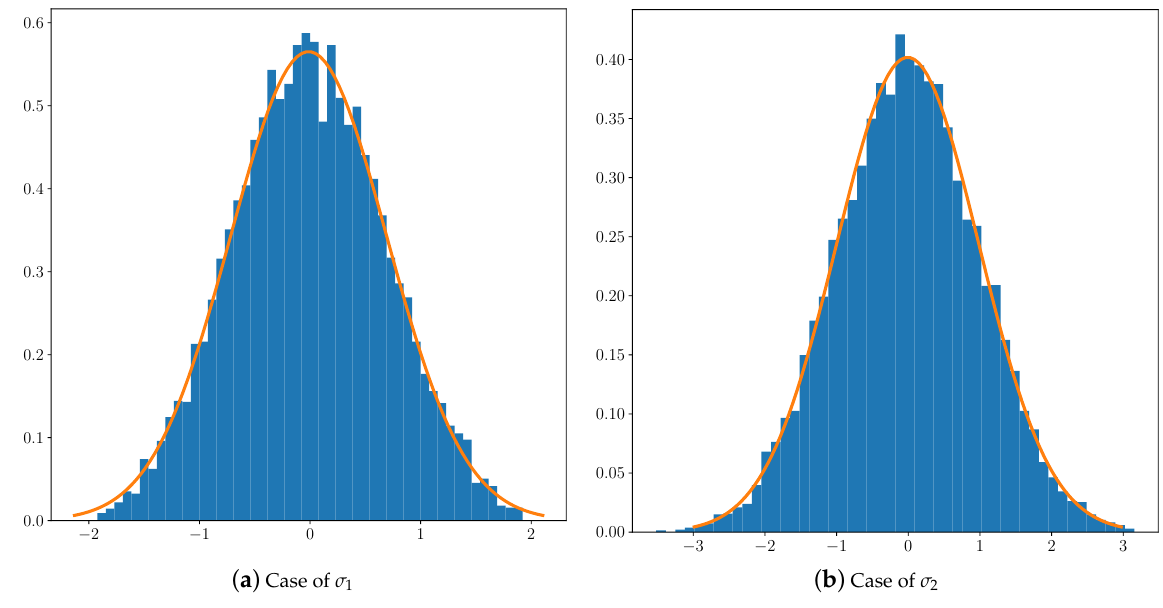
Figure 4. Histograms of the probability detection distribution density of the target moving at a constant velocity. These graphs allowed us to estimate the SV’s detection probability P det at its various initial positions. Now, Equation (6) may be approximated